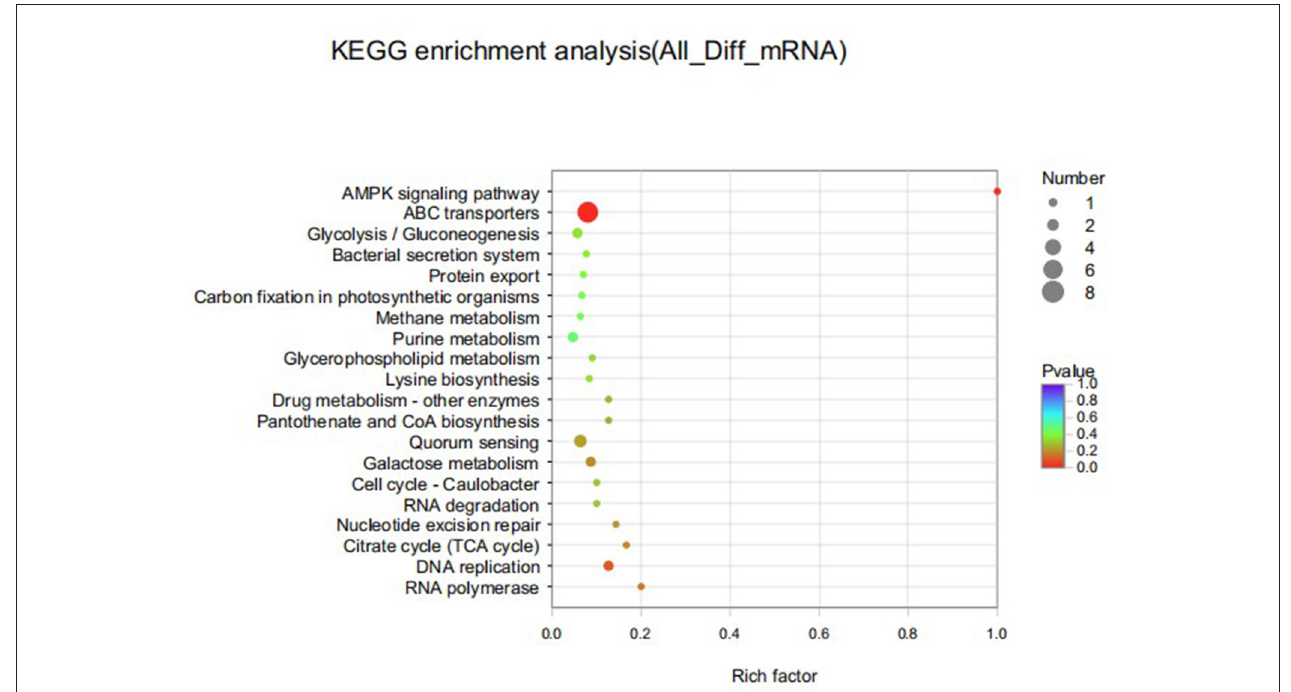
FIGURE 9 | Top 20 KEGG pathways enriched for differentially expressed genes of S. iniae strain HT after treatment with thymol. The X-axis represents Rich factor. The Y-axis represents KEGG pathway entry.